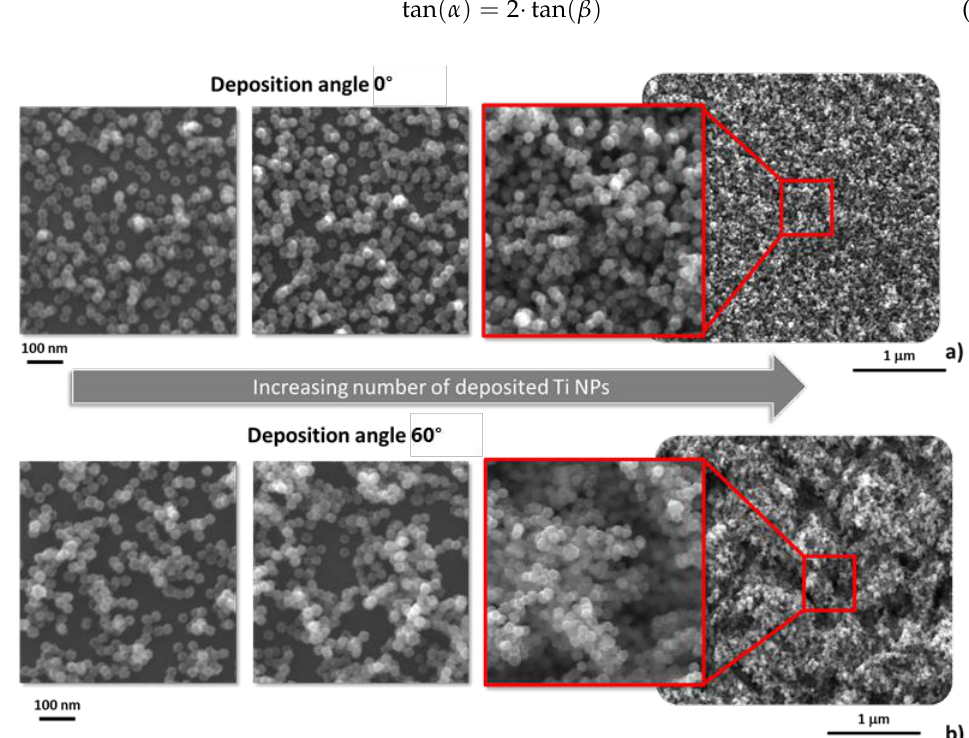
Figure 7. Top-view SEM images of growing Ti nanoparticle films deposited at ( a ) zero tilting angle and ( b ) tilting angle of 60°.